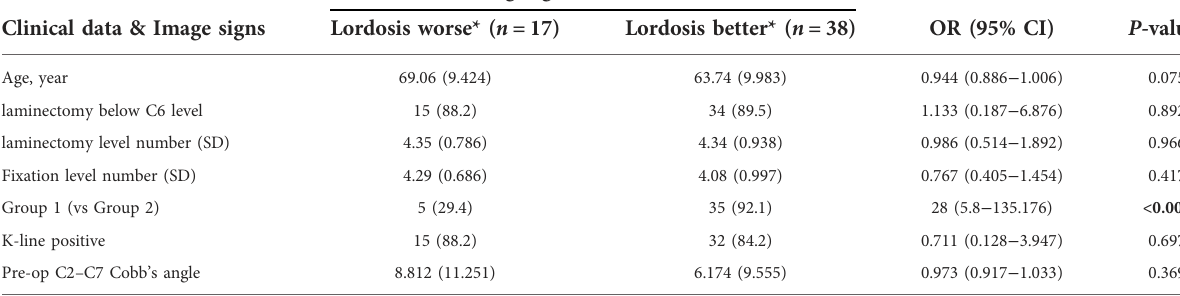
Table 3 Predictors of better postoperative cervical lordosis in univariate analysis.